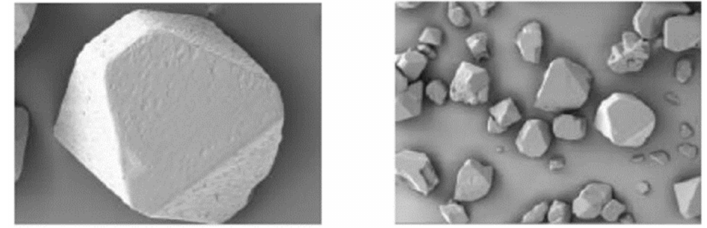
Figure 5. Morphology of β -HMX crystals obtained from DMSO by cooling